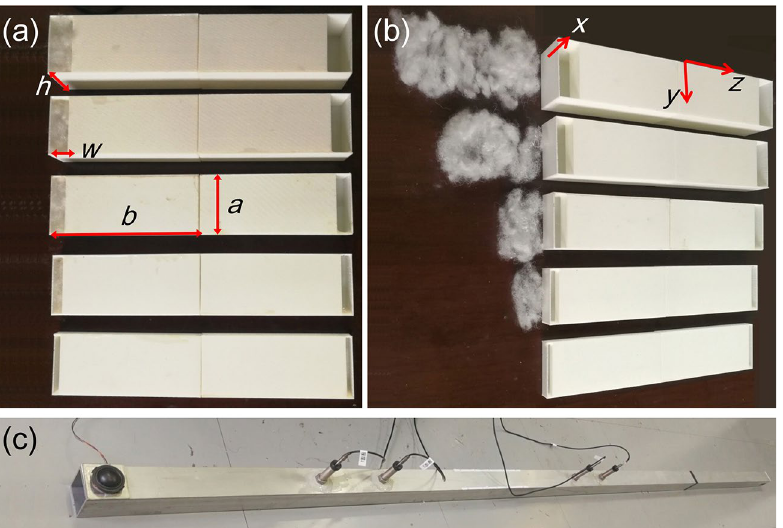
Figure 4. Photographs of experimental samples and setup. ( a ) Five experimental samples. Each sample consists of two boxes with curled, one-end-closed channel inside, where the left box contains appropriate amounts of porous media (polyester pillow stuffing) and the right box is hollow. ( b ) The same as ( a ) but with the porous media taken out from the sample. ( c ) The impedance tube for sound absorption measurements.